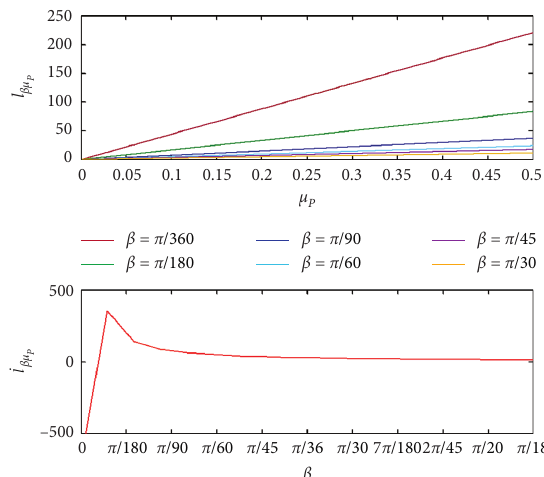
Figure 8: The relationship between the length of the gravity block l well inclination angles β and the relationship between the change rate of the gravity block length _ l